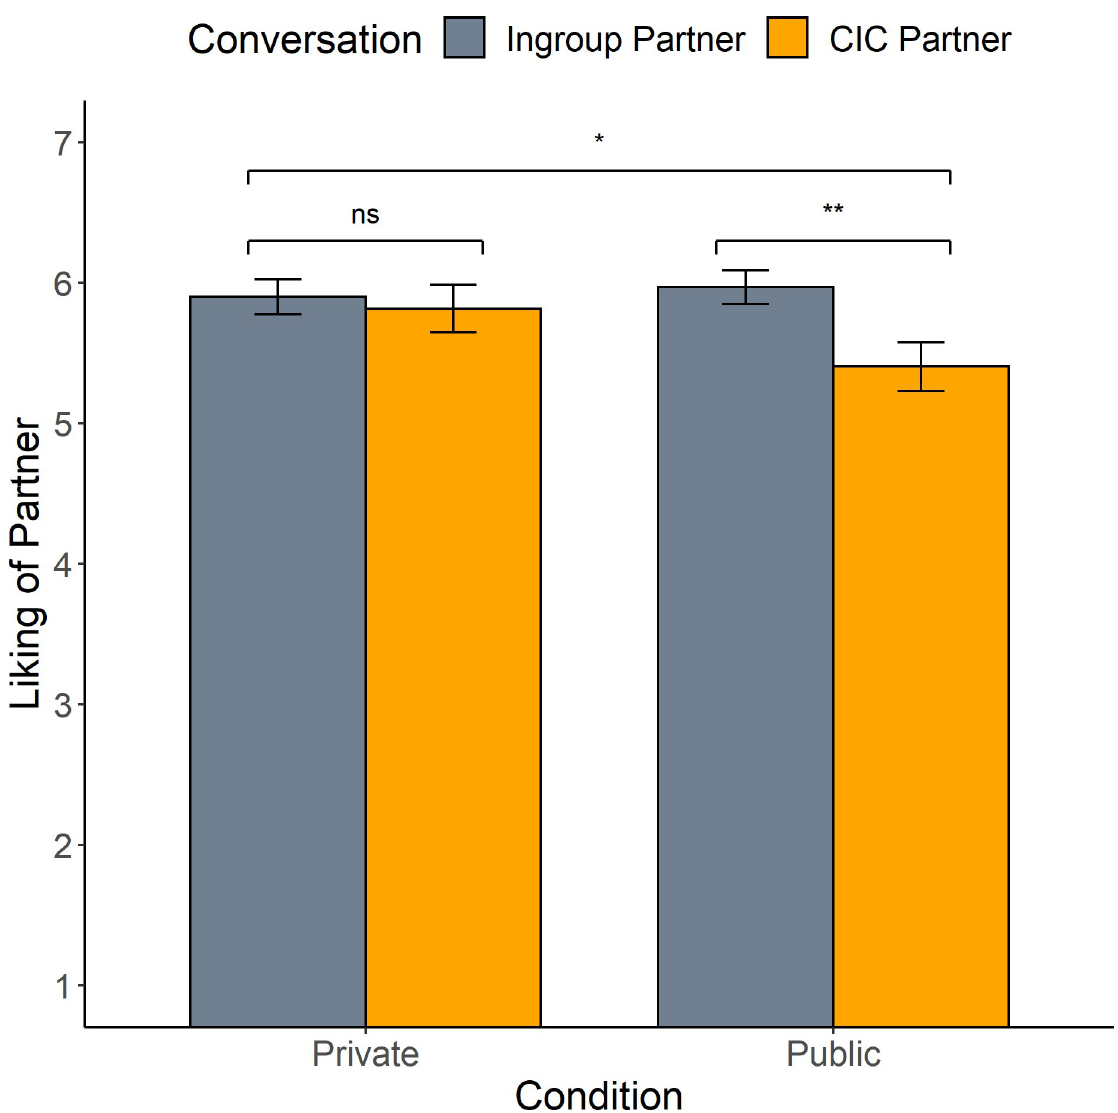
Fig 3. Strength of conversation partner liking: Condition by partner. Note . Shown here is liking of conversation partner, reported on a scale of 1 (strongly disagree) to 7 (strongly agree). Driving the interaction of condition by partner ( n = 122) is the difference in liking of conversation partner for the public condition, such that participants liked their attitudinal ingroup member from the initial conversation more than their CIC partner. � p < .05 for the main effect of partner (i.e., ingroup vs CIC-partner). �� p < .01 for the simple comparison of ingroup partner vs CIC-partner in the public